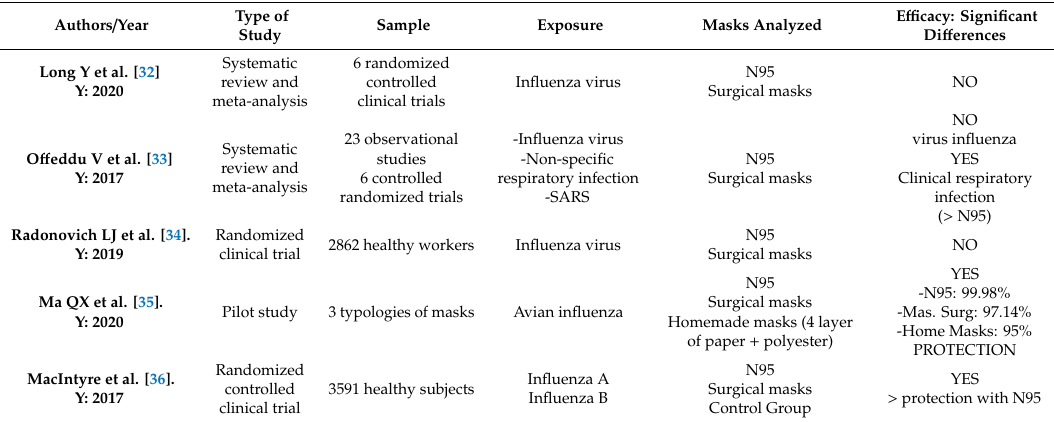
Table 2. Analysis of preventive masks used for protection against